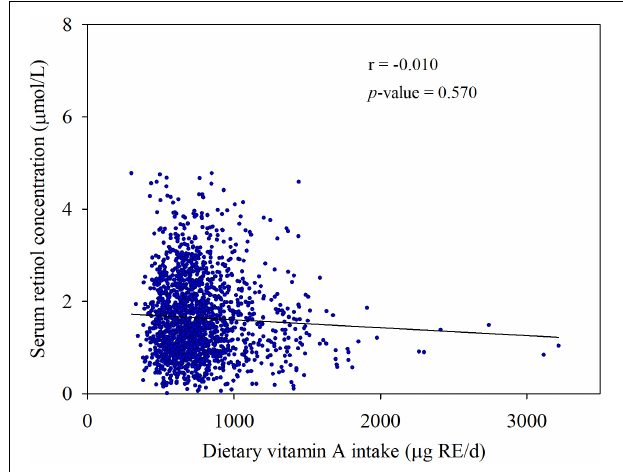
FIGURE 5 | Associations between serum retinol concentration and dietary vitamin A intake. Partial r and p -values were obtained after adjustment for age, gender, current smoker, current drinker, exercising regularly, education level, physical activity, dietary energy intake, dietary lipid intake, and